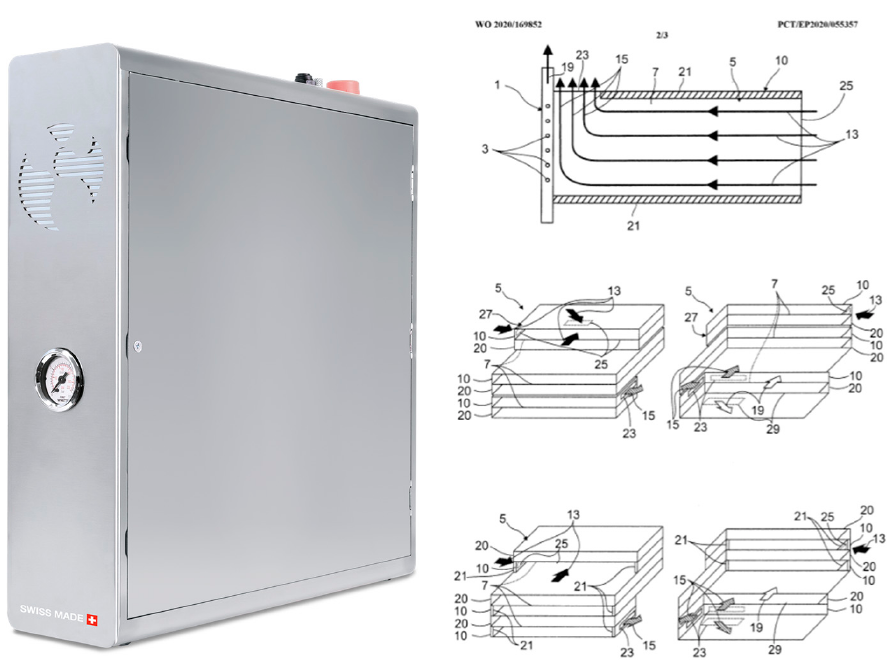
Figure 4. The EVOdrop turbine operation principle. Figure 5 illustrates the EVOdrop filter.